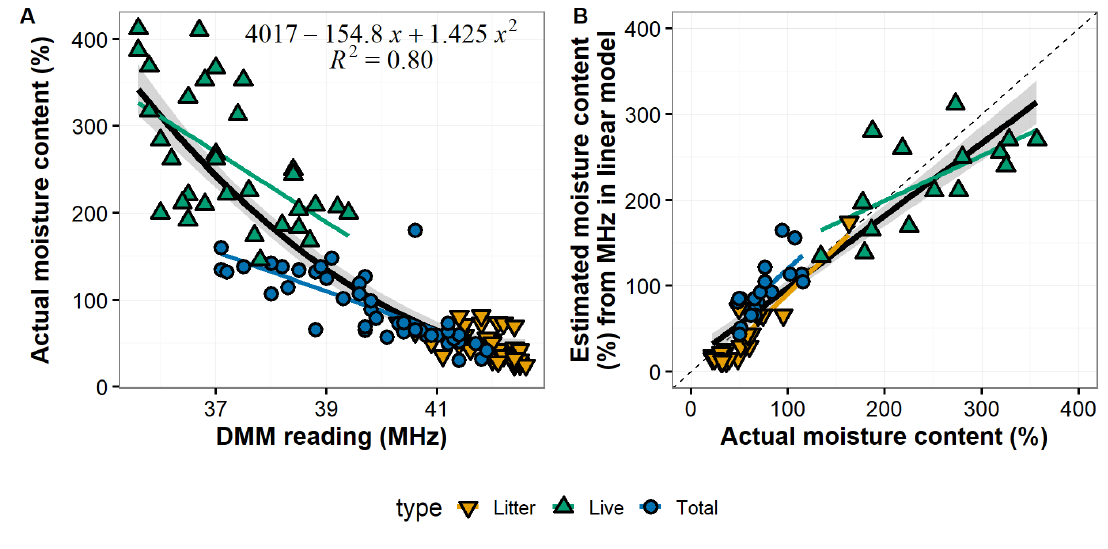
Figure 2. Fits for the training ( A ) and validation ( B ) datasets, in which points are plotted as three fuel types with linear regression lines for each. B. inermis and P. pratensis are combined. ( A ) Actual (oven-dried) moisture content of grass fuel samples tested in the Campbell Scientific Duff Moisture Meter (DMM600) plotted against permittivity values, the raw data generated by the DMM600. A second-order polynomial line, in black, is fit to the entire training dataset, for which the regression equation is given in the upper right corner. Overall statistical significance was tested via LMER. The main trend between WC and freq was significant and highly correlated ( R 2 = 0.86, χ 2 = 60.3, p < 0.001). LMER model with fuel type term was significantly different ( χ 2 = 36.4, p < 0.001) but species term was not ( χ 2 = 0.48, p = 0.49). ( B ) Estimated moisture content in a holdout validation dataset as a percentage of dry weight derived by fitting DMM600 permittivity values into the polynomial regression equation from (A), plotted against actual (oven-dried) moisture content of DMM600 samples ( R 2 = 0.87, χ 2 =